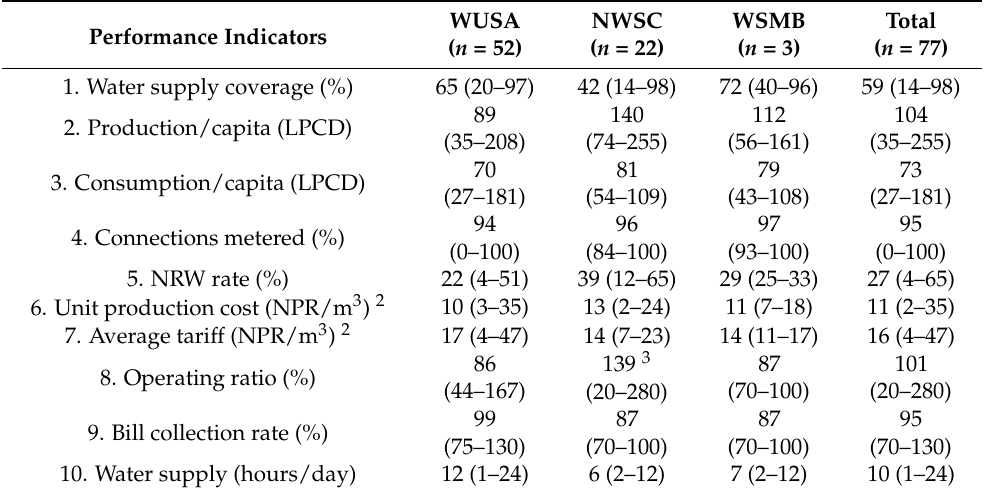
Table 3. Performance assessment of service providers 1